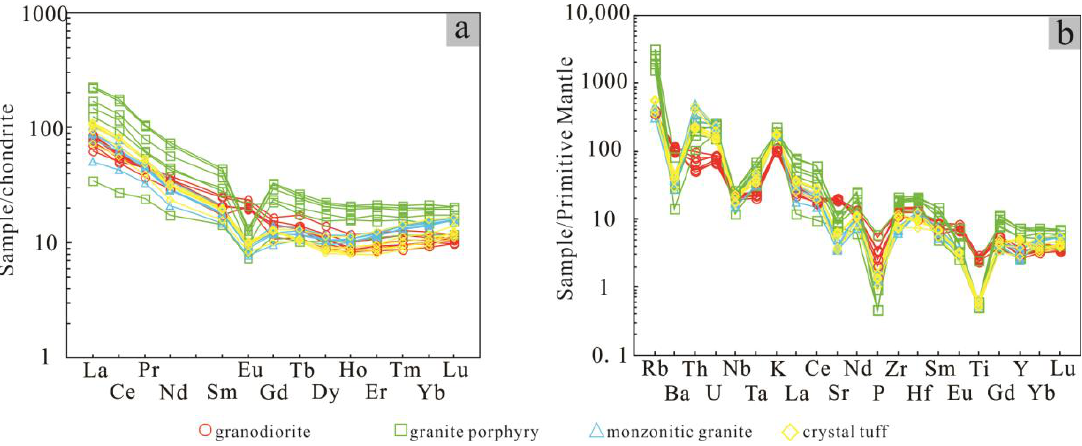
Figure 6. ( a ) Chondrite-normalized rare Earth element (REE) patterns (chondrite REE values from [53]); and ( b ) primitive-mantle-normalized trace-element spider diagram (primitive-mantle values from [54]) for granitic rocks and crystal tu ff of the Hutouya